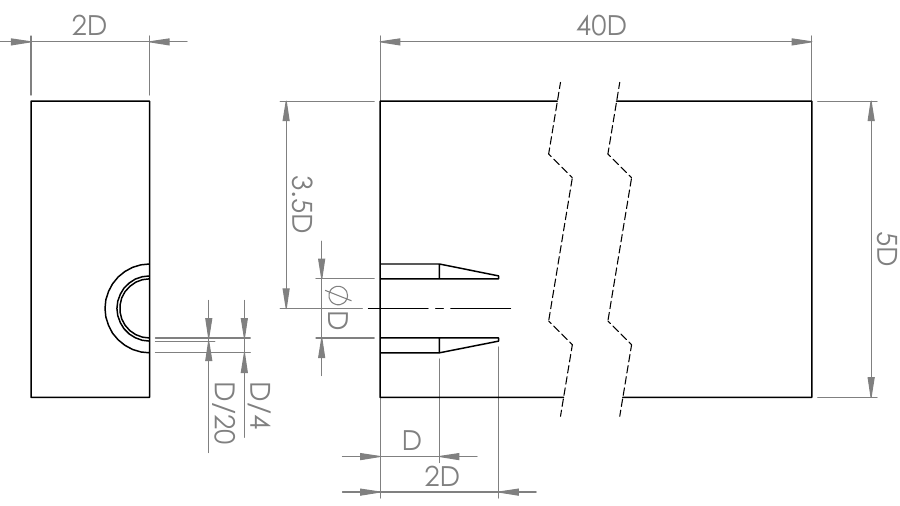
Figure 2. Schematic drawing of the fluid domain. Left: bottom view. Right: side view. 130 The computational mesh is generated using the ICEM-CFD software as a structured multi-block mesh and contains a total of 1.3 million hexahedral elements. The mesh is refined at the walls to accurately capture the boundary layer and at the jet shear layers. A y + smaller than unity was obtained on the entire wall surface. Figure 3 shows the volume Version December 3, 2021 submitted to Energies mesh at the bottom surface and symmetry plane.